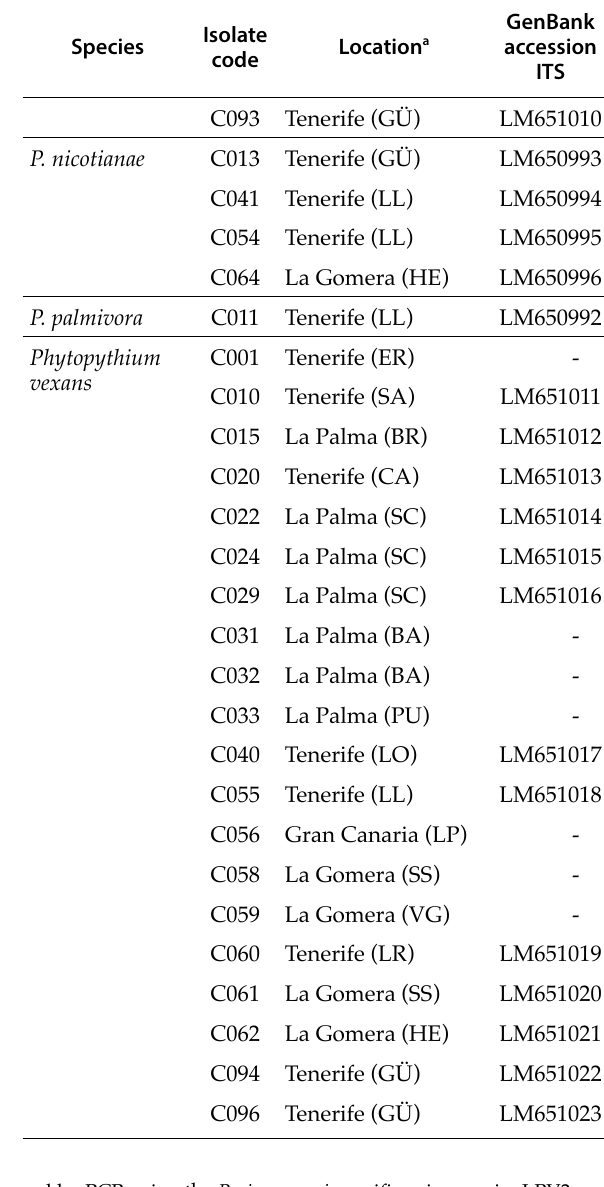
Table 1. Identity of Phytophthora and Phytopythium isolates based on morphology and ITS sequence data (one representa- tive isolate of each species isolated per orchard). GenBank accessions numbers of isolates that were used for phylogenetic analysis are provided.